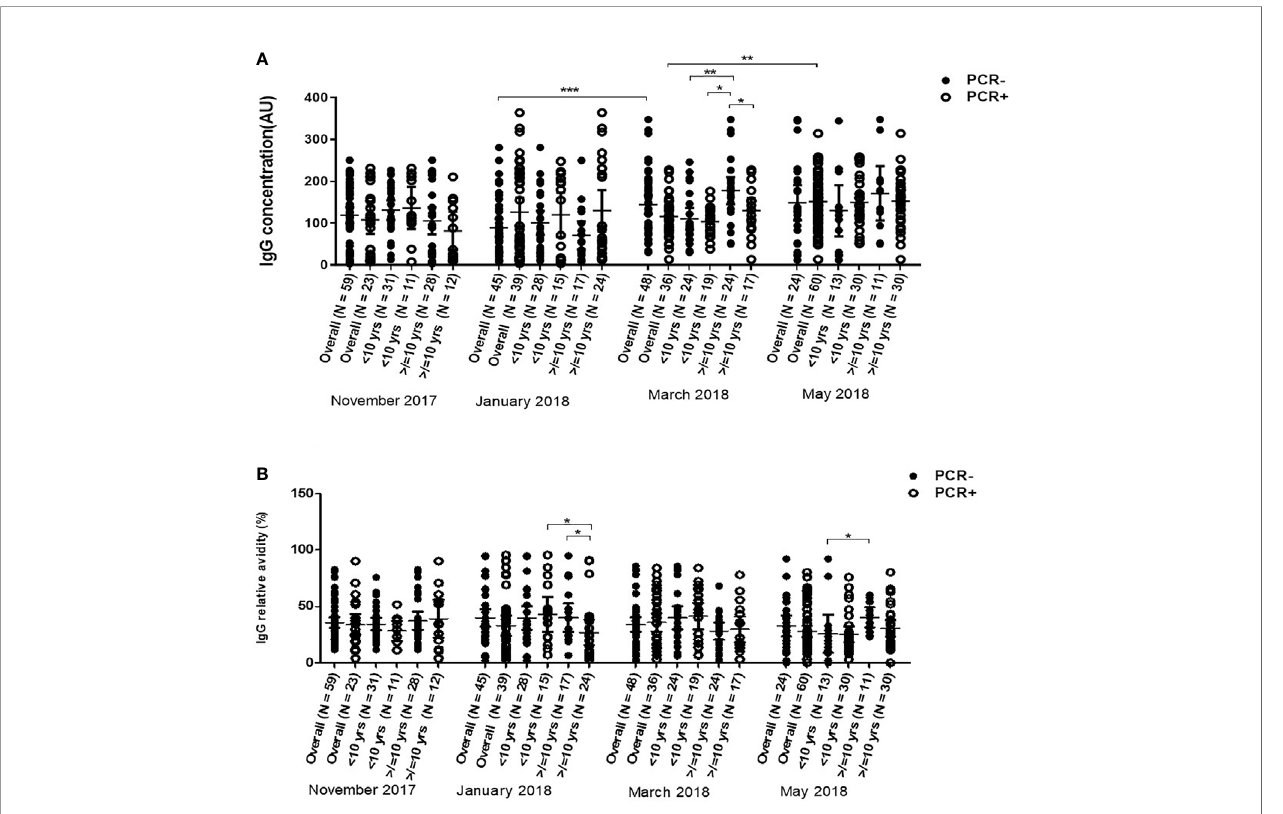
FIGURE 6 | Variations in of anti-Pfs230 IgG levels (A) and Relative avidities (B) in young children (<10 years) and older children ( ≥ 10 years) with (positive polymerase chain reaction test result) and without (negative-polymerase chain reaction test result) active P. falciparum infections over the dry season from November 2017 to May 2018. The number above each of the aligned dot plots represents the number of individuals in the group. The extent of statistically signi fi cant difference in measurements indicated by *, ** and *** represent P <0.05, P <0.01, and P <0.001